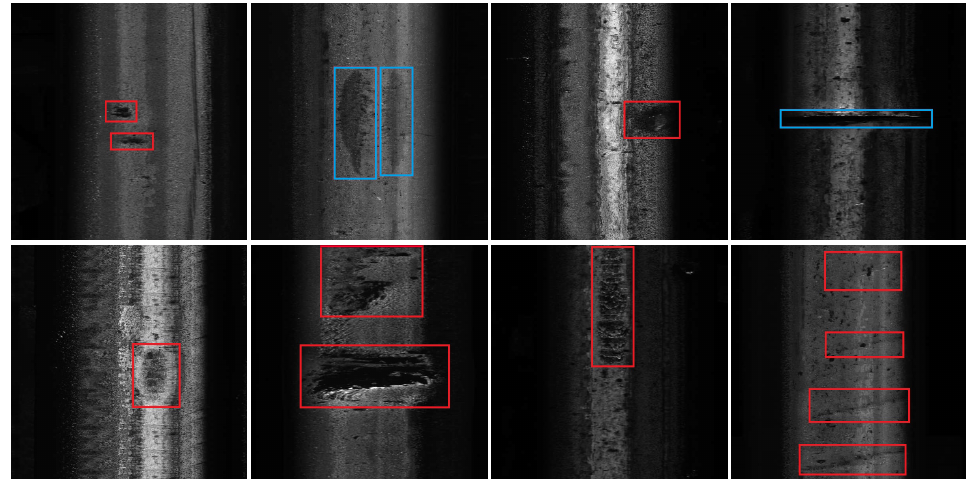
Figure 1. Samples of the rail defect dataset. From left to right, first row contains damage, dirt, unknown and gap, and second row contains dent, crush, scratch and slant.